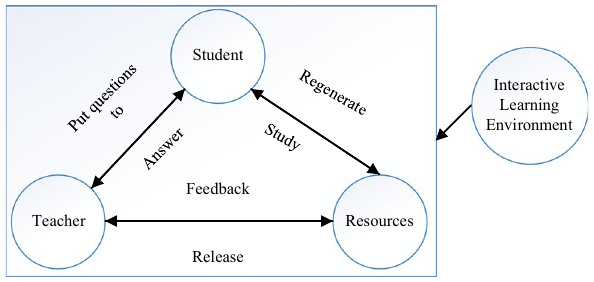
Fig. 3 Design of mobile learning interaction mode for smart